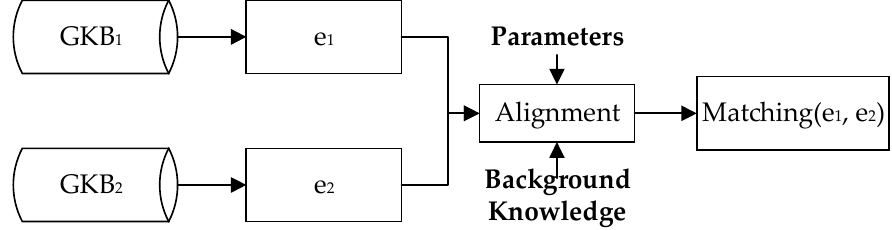
Figure 1. Schematic diagram for entity alignment of geographic knowledge bases (GKBs). (Note: GKB 1 and GKB 2 represent two geographic knowledge bases to be integrated, and e 1 and e 2 are two entities to be aligned from GKB 1 and GKB 2 , respectively.).